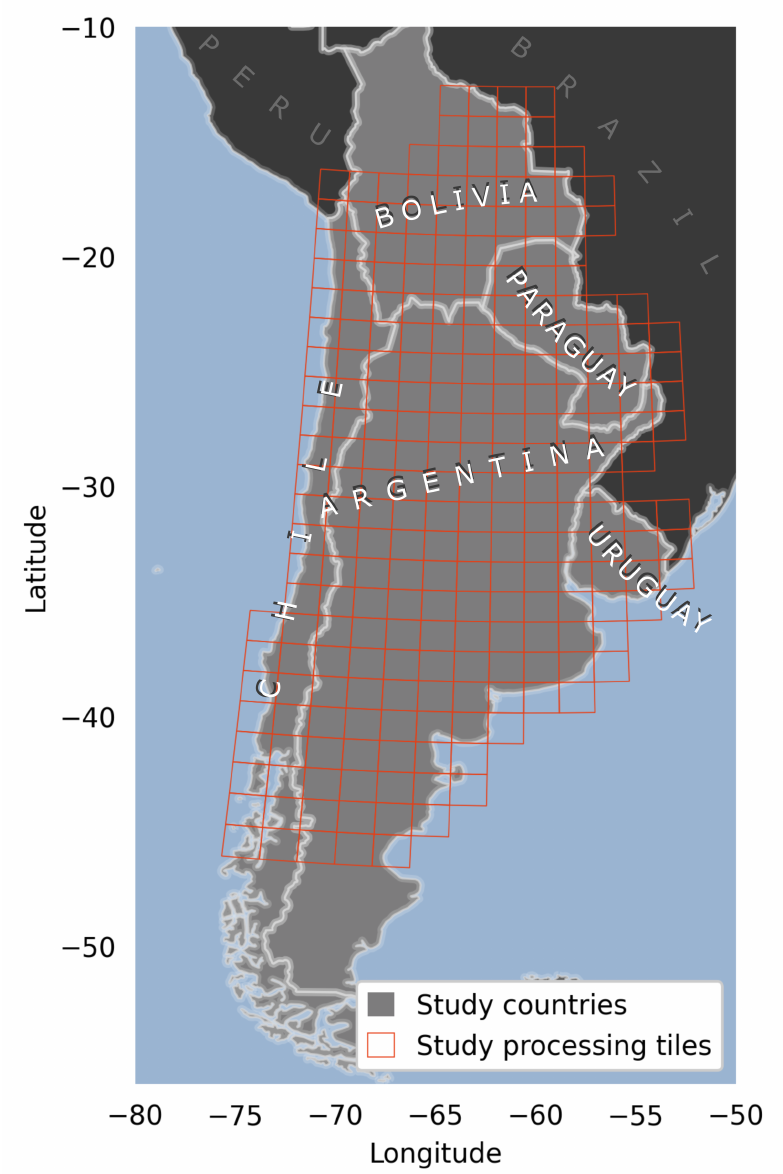
Figure 1. The South American Southern Cone region. The study area encompasses five countries of southern South America: Argentina, Bolivia, Chile, Paraguay, and Uruguay. This region (excluding Bolivia) is often referred to as the Southern Cone. The grids outlined in red are the Landsat processing tiles. As illustrated, the data processing area includes the entirety of Paraguay and Uruguay. However, the northern border excludes northwestern Bolivia, as the objective in this study was to include the agricultural lowlands. In the southern portion of the study area we limited the data processing to around − 47 ◦ latitude, as the data density declined substantially farther south and limited the quality of time series